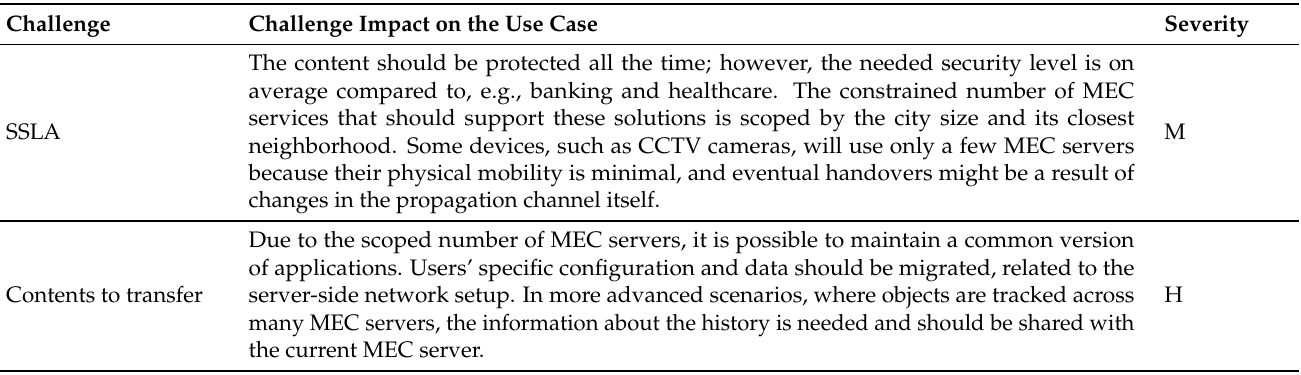
Table 11. Challenges in the city surveillance use